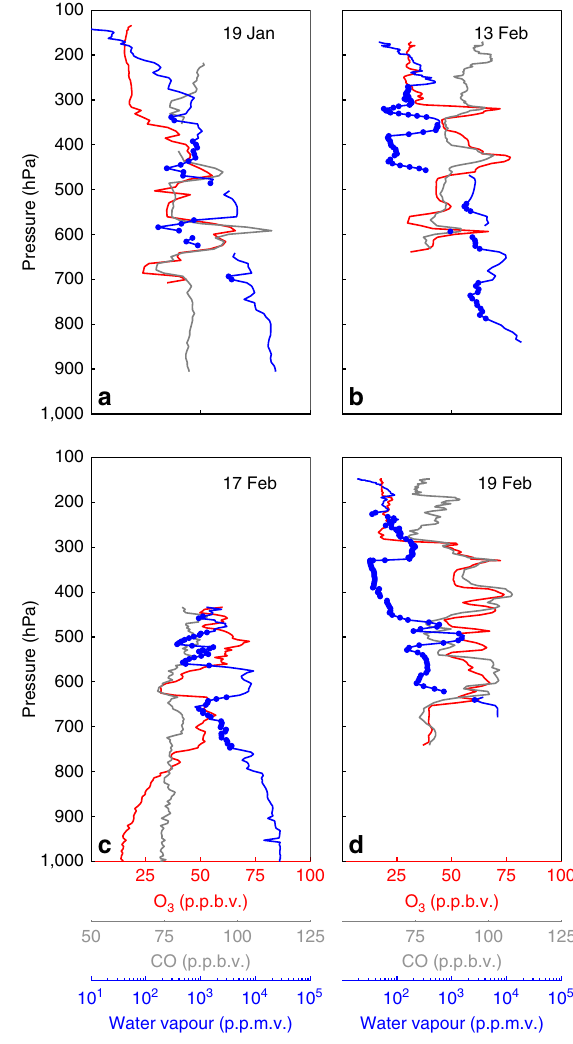
Figure 2 | Ozone, water vapour and CO profiles in the TWP. Sample profiles of 10s averaged O 3 (red), CO (grey) and H 2 O (blue) from four flights during CONTRAST ( a , b , d ) and CAST ( c ). Blue circles indicate measurements of H 2 O mixing ratios for which RH o 20%. RH is with respect to water and with respect to ice for temperatures above and below 273K, respectively. Vertical profiles have a characteristic horizontal length of B